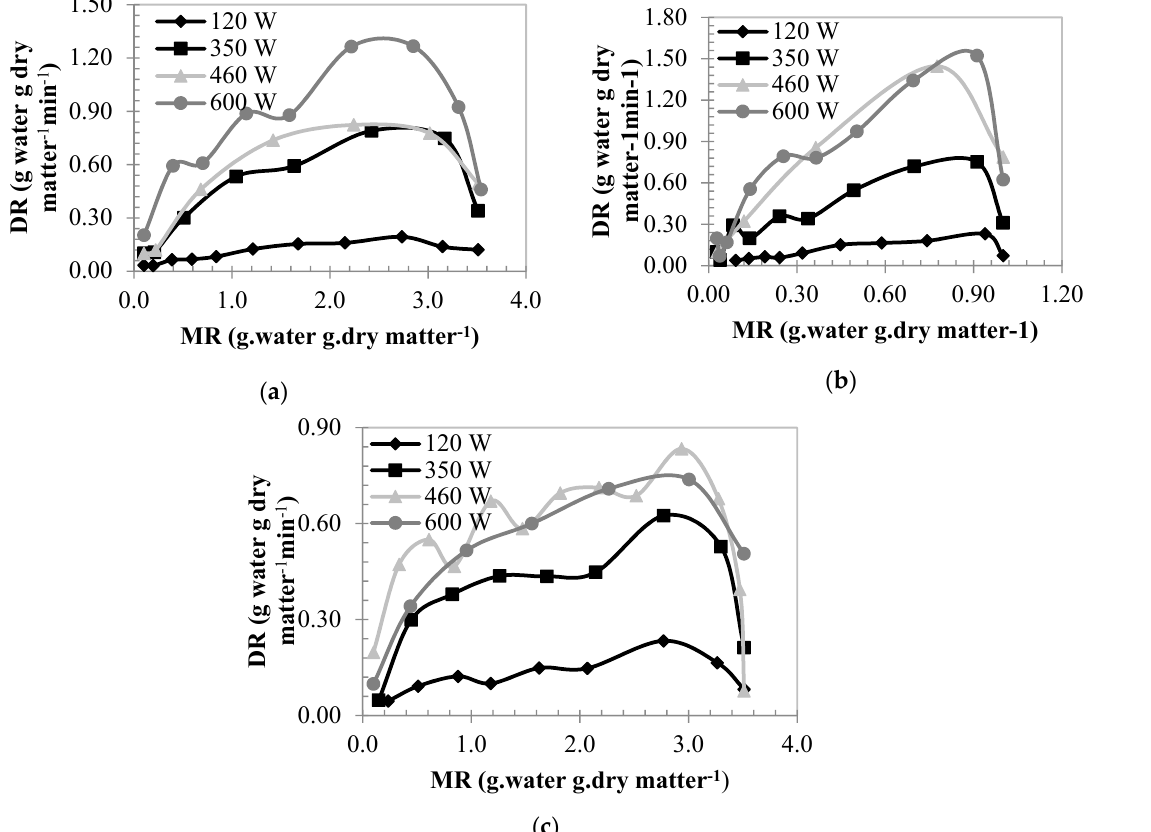
Figure 4. Variation of the drying durations with the changes in the drying rate at different powers. ( a ) 5mm, ( b ) 7mm, ( c ) 9mm.